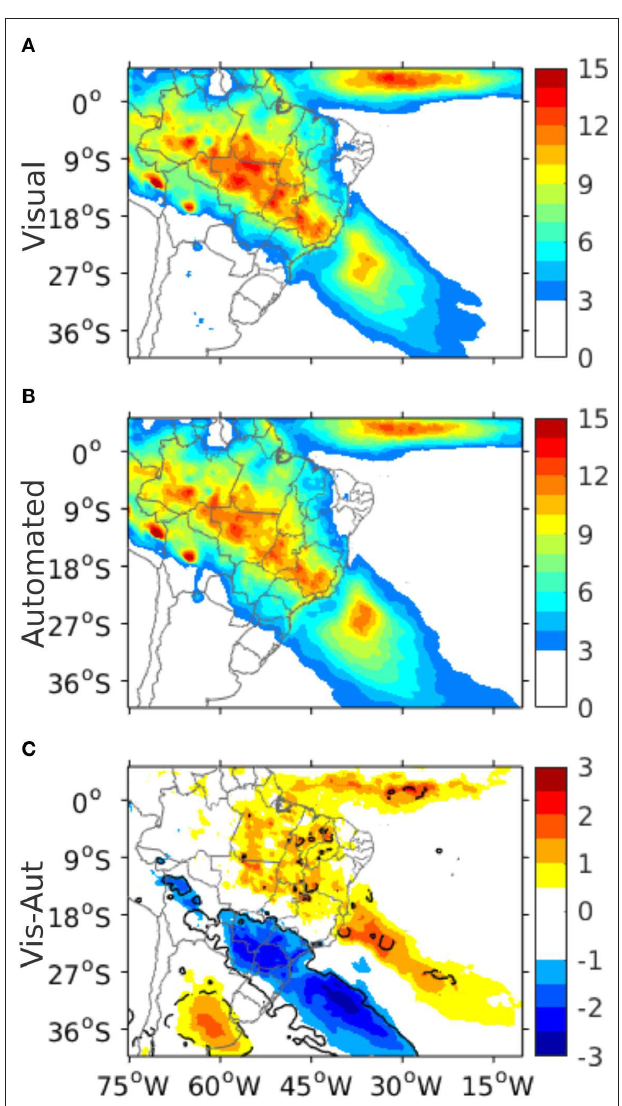
FIGURE 6 | Composite of daily mean precipitation (mm day − 1 ) for visual (A) and automated (B) SACZ active days and the difference between them (C) with significant t -test values ( > 95%) inside the solid and dashed